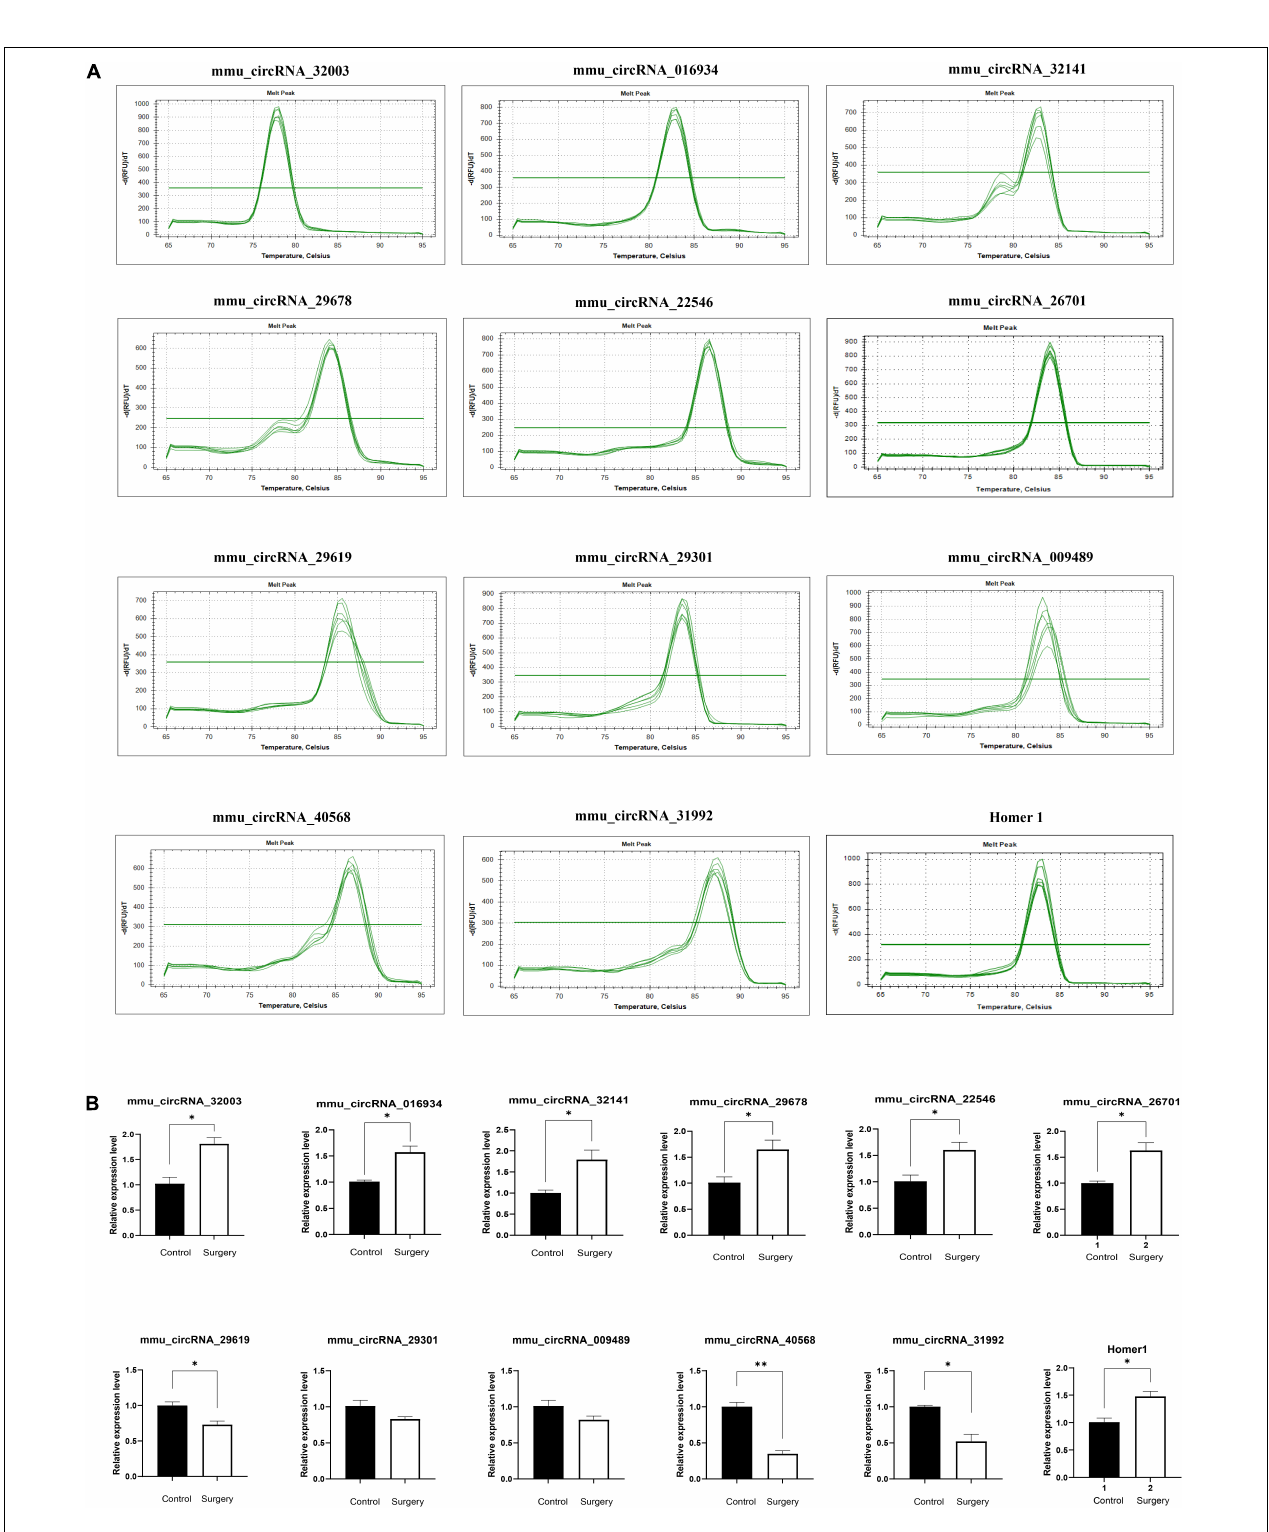
FIGURE 6 | Amplification and identification of differentially expressed circRNAs. (A) The melt curves of the identified distinguishable expressed circRNAs. (B) qRT-PCR showing the expression levels of circRNAs between the two groups. Homer1 mRNA was used to detect the expression level of Homer1 gene, while mmu_circRNA_26701 was a circular RNA transcribed from Homer1 gene. Data are presented as means ± SEM, analyzed by Student’s t -test. ∗ P < 0.05, ∗∗ P < 0.01. ( N = 6).